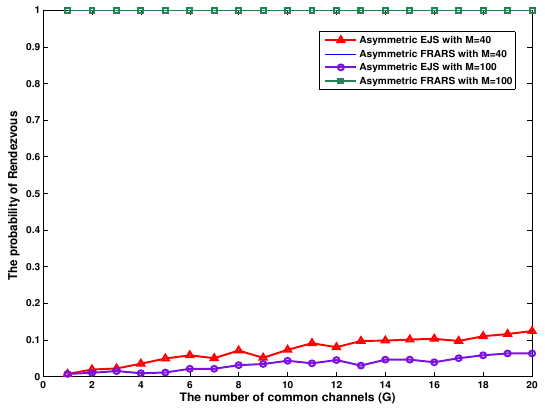
Figure 10. The probability of rendezvous for the asymmetric FRARS and EJS schemes under CDJA attacks with | m 1 | = | m 2 | = | M | /2, M = { 40,100 } , and G = { 1 · · · 20 }